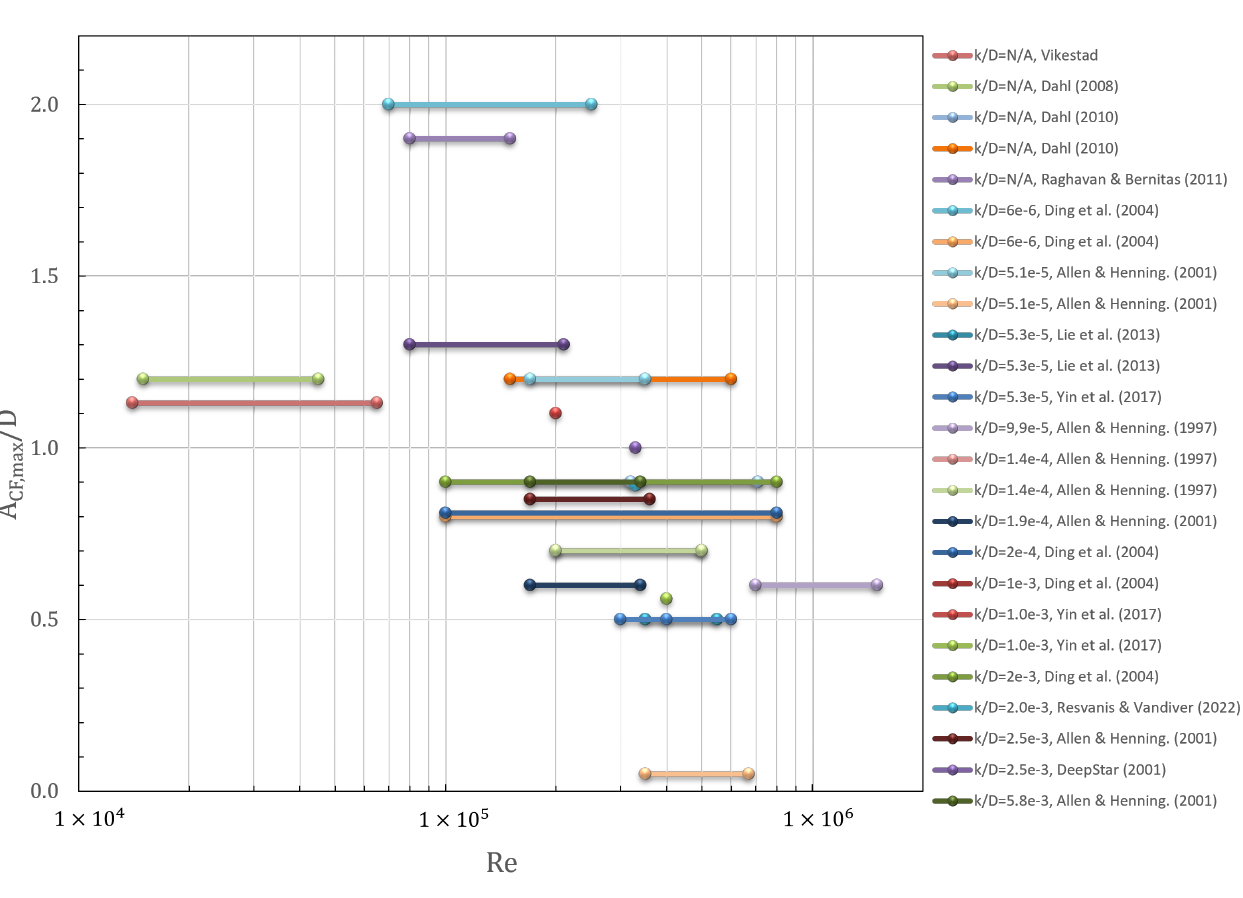
Figure 5. Dimensionless maximum CF VIV amplitude ratio vs. Reynolds number